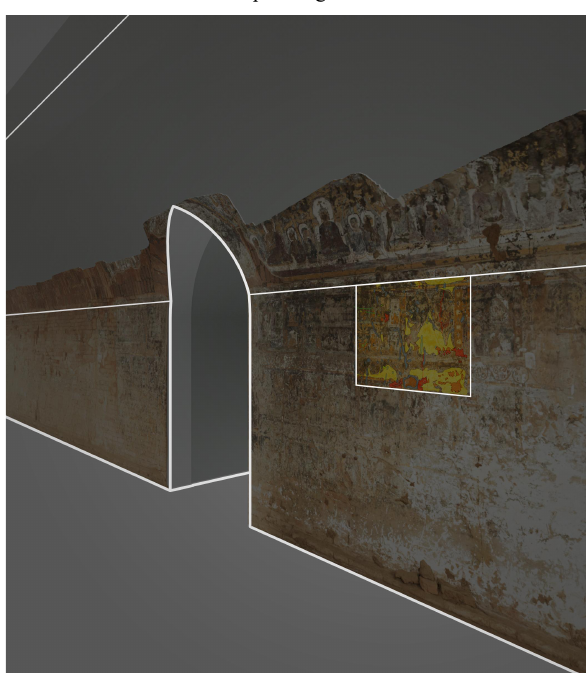
Figure 11. Laser scan in BIM of west wall painting.